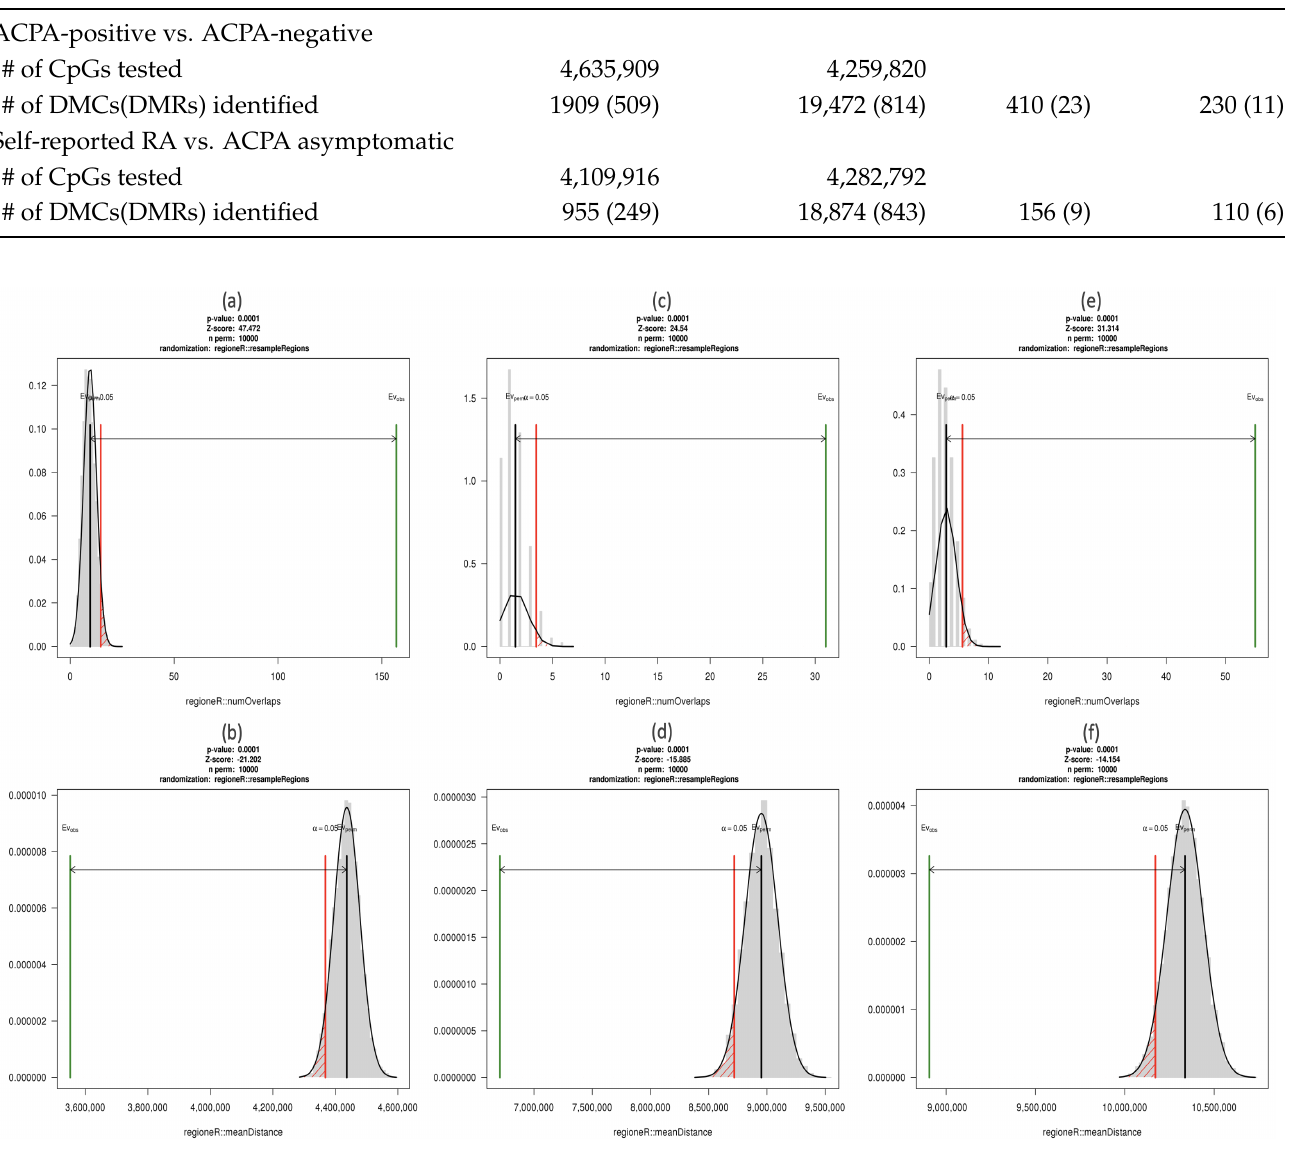
Figure 6. Null distributions and corresponding 0.05 p -value thresholds for overlap or agreement, from 10,000 permutations in different cases: ( a ) the number of overlapping ACPA-associated DMCs between two datasets; ( b ) the mean distance between ACPA-associated DMCs in two datasets; ( c ) the number of overlapping ACPA-associated gDMCs between two datasets; ( d ) the mean distance between ACPA-associated gDMCs in two datasets; ( e ) the number of overlapping RA- associated DMCs between two datasets; ( f ) the mean distance between RA-associated DMCs in two datasets. The X-axis represents the number of overlapping sites in ( a , c , e ) and the mean distance in ( b , d , f ), the Y-axis specifies the density so that the histogram has a total area of one. The green vertical bars represent what we actually observed in each case. The sampling universe for permutations was CpGs tested in both